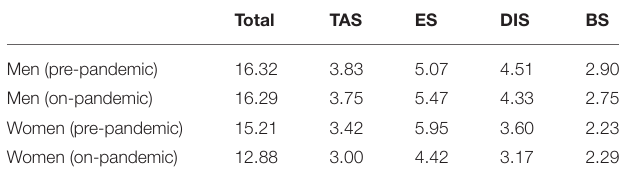
TABLE 5 | SSS scores by